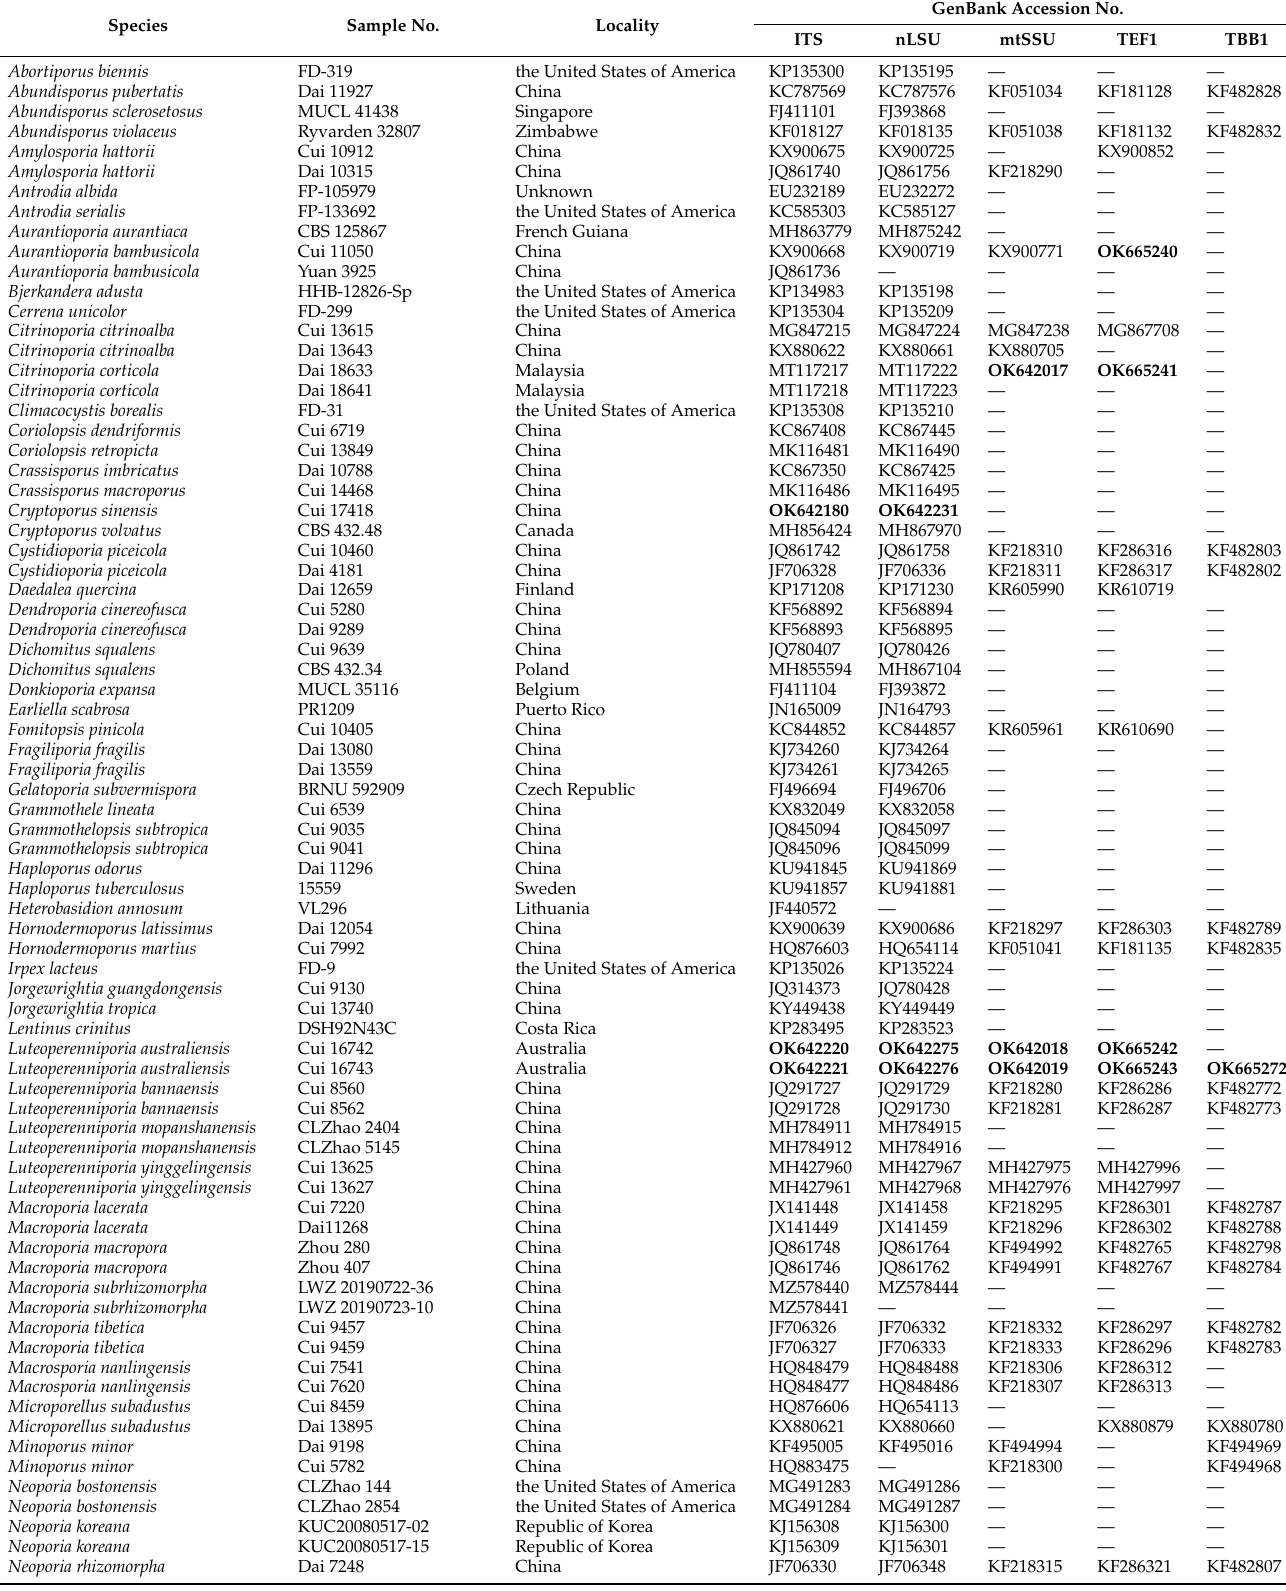
Table 1. Samples and GenBank accession numbers of sequences used in this